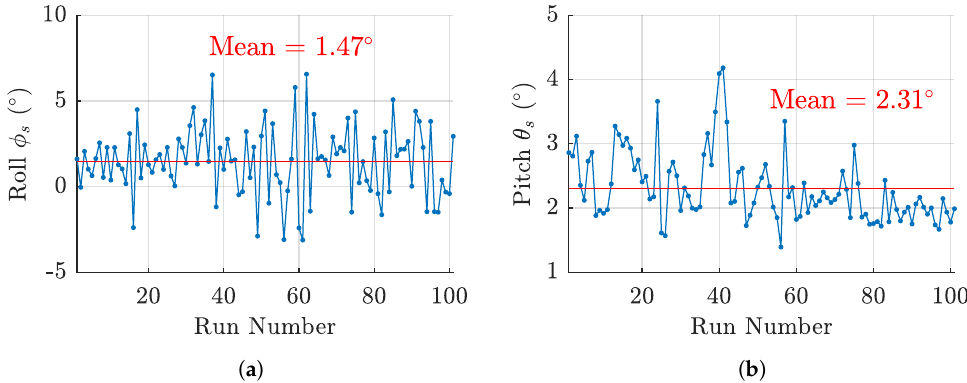
Figure 13. Evolution of the roll ( a ) and pitch ( b ) angles for all the runs achieved with the kite